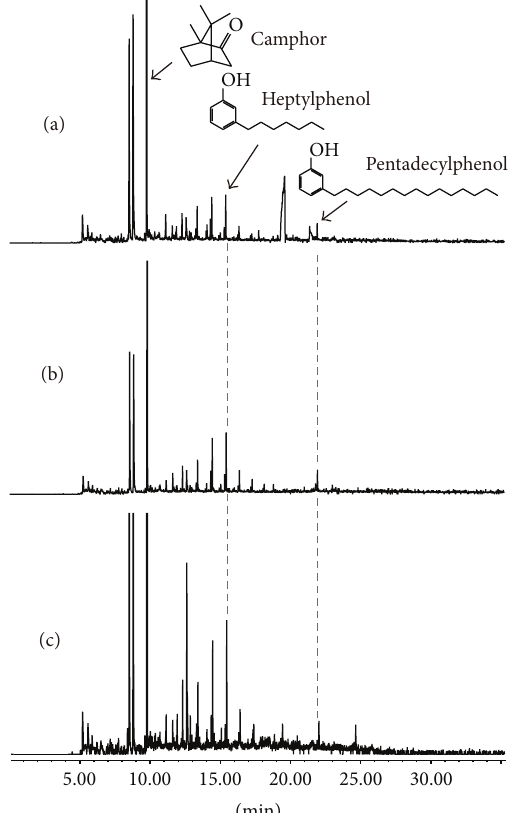
Figure 6: Ion chromatograms of the 𝑚/𝑧 108 fragment ion of the alkylphenol of Sample Y (a), Sample G (b), and Sample R